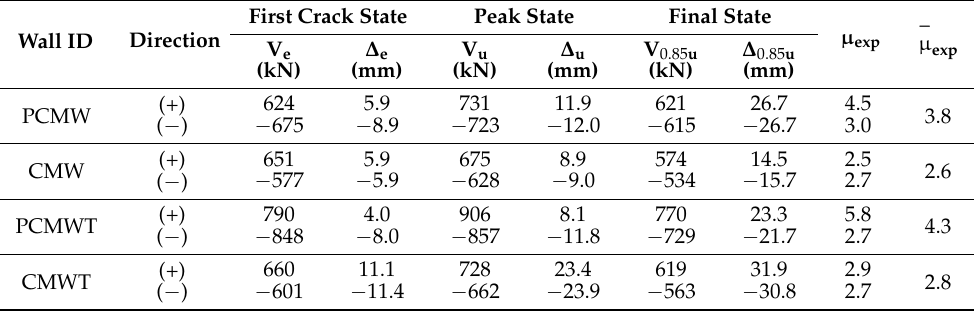
Table 2. Test results and experimental displacement